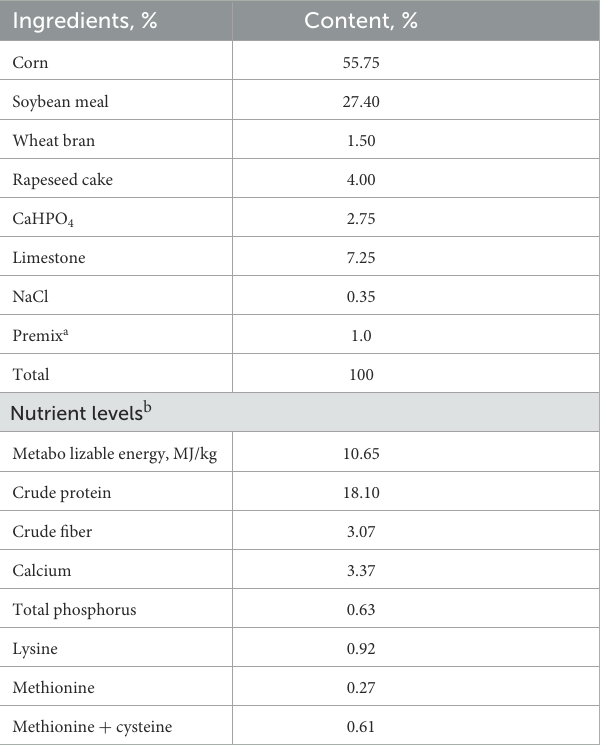
TABLE 1 Basic diet formula and nutrition